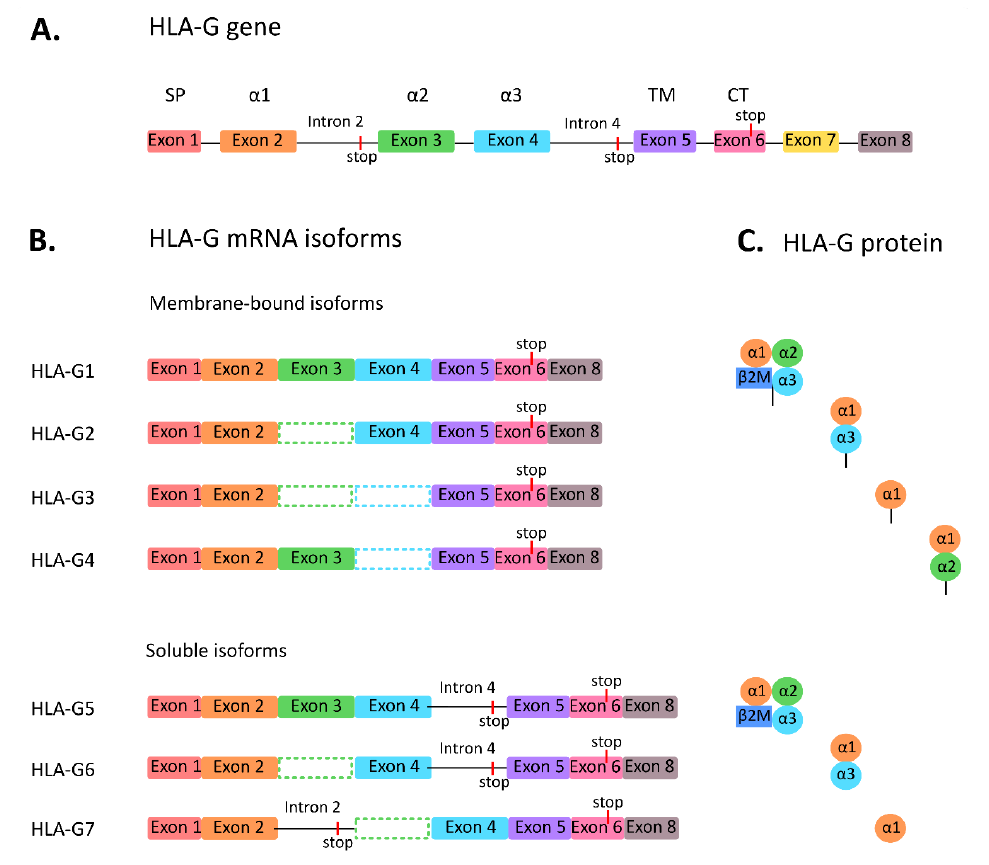
Figure 1. Human leukocyte antigen G (HLA-G) isoforms. ( A ) Overview of the HLA-G gene, ( B ) the seven mRNA splice variants of the HLA-G gene and ( C ) its resulting protein structures. Abbreviations: cytoplasmic tail (CT), signal protein (SP), transmembrane (TM).